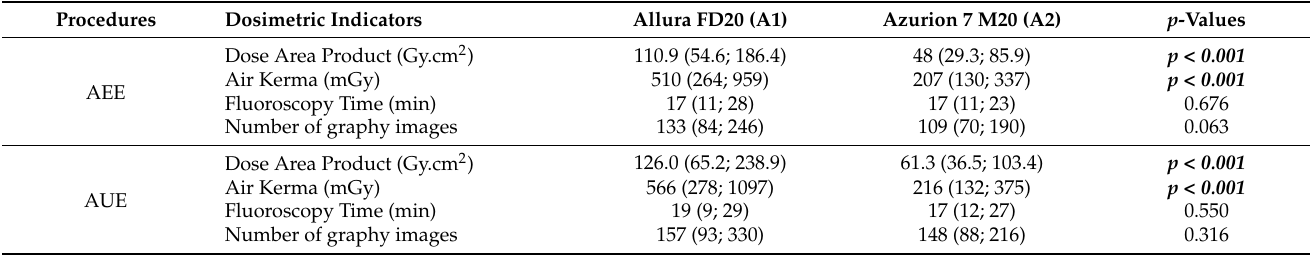
Table 2. Comparison of the dosimetric indicators between the Allura FD20 (A1) and Azurion 7 M20 (A2) C-arms systems for 7 embolization